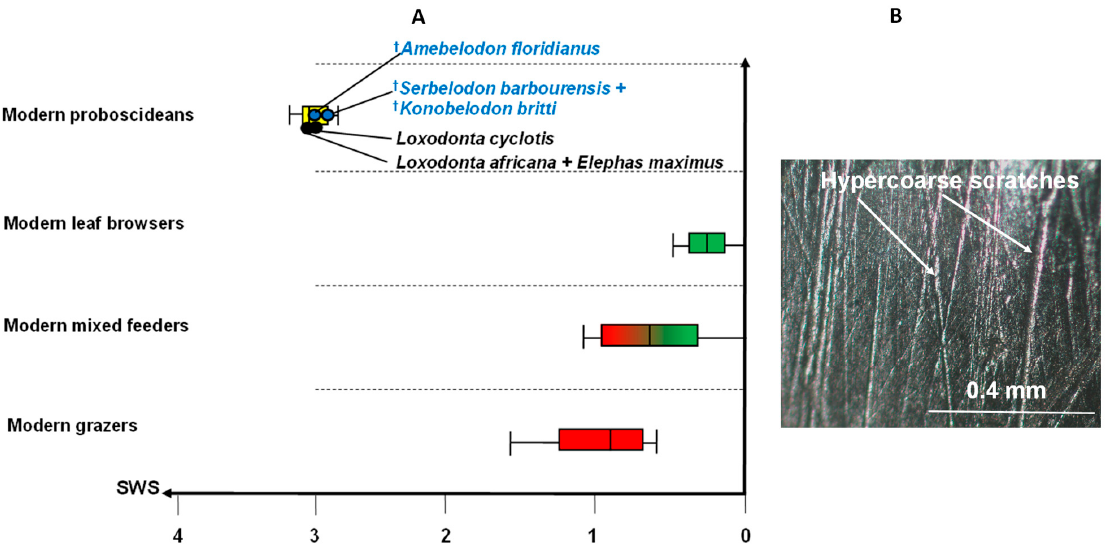
Figure 6. Scratch width scores for fossil and extant proboscideans and example of hypercoarse scratches found on proboscidean molar teeth. Box plot of scratch width scores for extant ungulates and proboscideans ( A ) and enamel surface of UF 38207 m2— Serbelodon barbourensis (lower second molar) showing the hypercoarse scratches typical of proboscideans and bark consumption ( B ). The box represents the central 50% of the scratch values and the bars represent the range (minimal and maximal values).